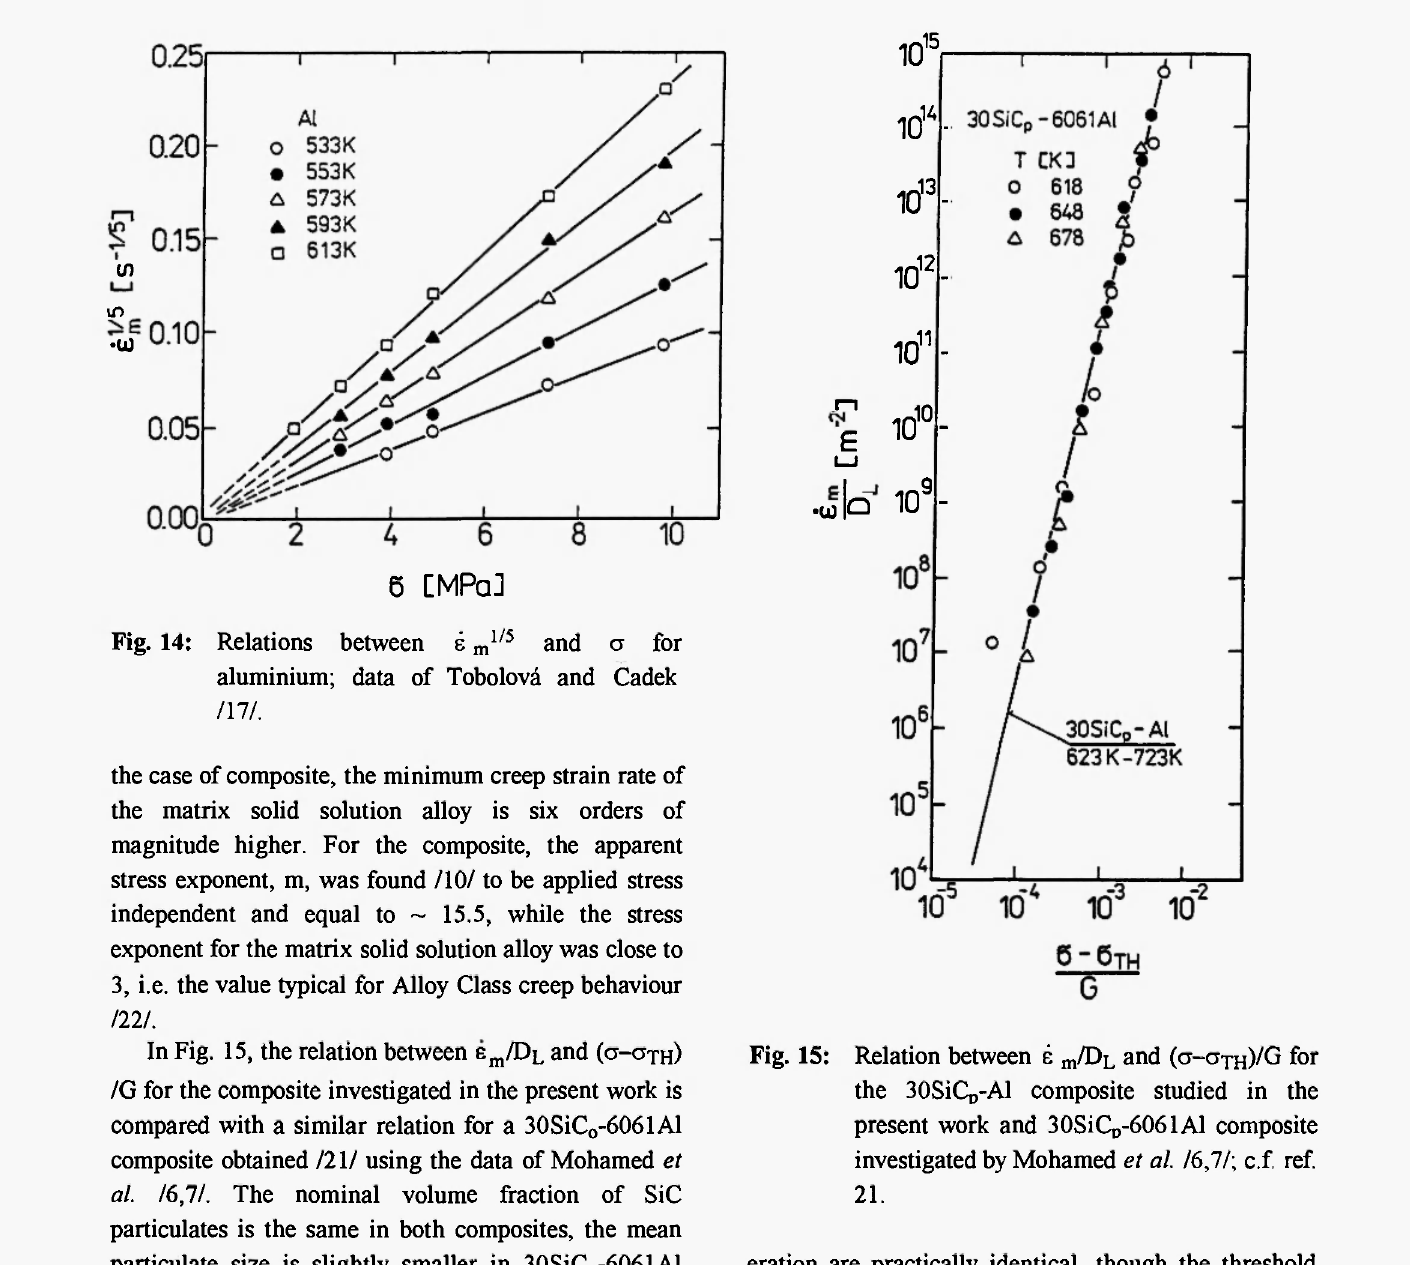
Fig. 15: Relation between έ